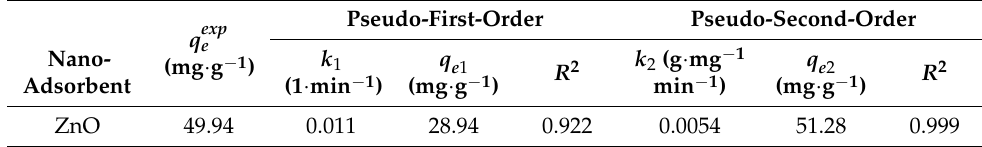
Table 3. Kinetic adsorption parameters for pseudo-first-order and pseudo-second-order